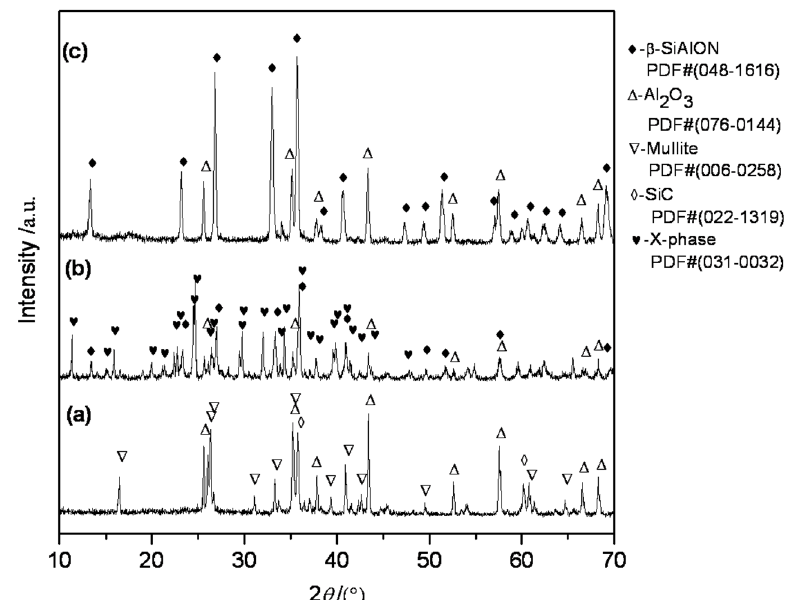
Figure 1. X-ray diffraction patterns of ( a ) B1 (AC); ( b ) B2 (NA); ( c ) B3 (NC).